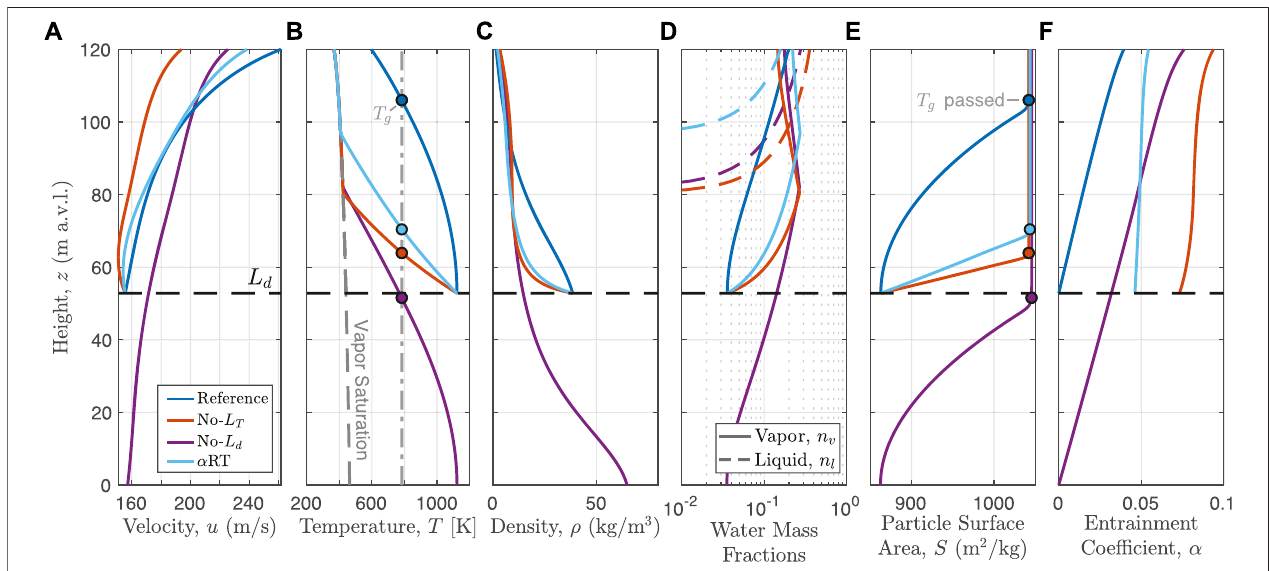
FIGURE 6| ExampleMWI model parameters versus position in the water layer above the vent for a single simulation at q c = 1.03 × 10 8 kg/s, and Z e = 120 m. Four different water entrainment scenarios are shown: the Reference scenario using an entrainment condition modi fi ed by both decompression and crossover length scales (blue), a scenario with no scaling for turbulent mixing length ( no-L X , red), a scenario with no decompression length scale, where entrainment initiates immediately at the vent ( no-L d , purple), and a scenario using the weight Rayleigh-Taylor entrainment mode of Eq. 35 ( α RT scenario, light blue). (A) Vertical velocity. (B) Jet mixture temperature. (C) Jet bulk density. (D) Jetwaterliquid and vapormassfractions. (E) Speci fi csurface areaofpyroclasts. (F) Local entrainmentcoef fi cient.Coloredcircles in (B,E) highlight the crossing of the glass transition